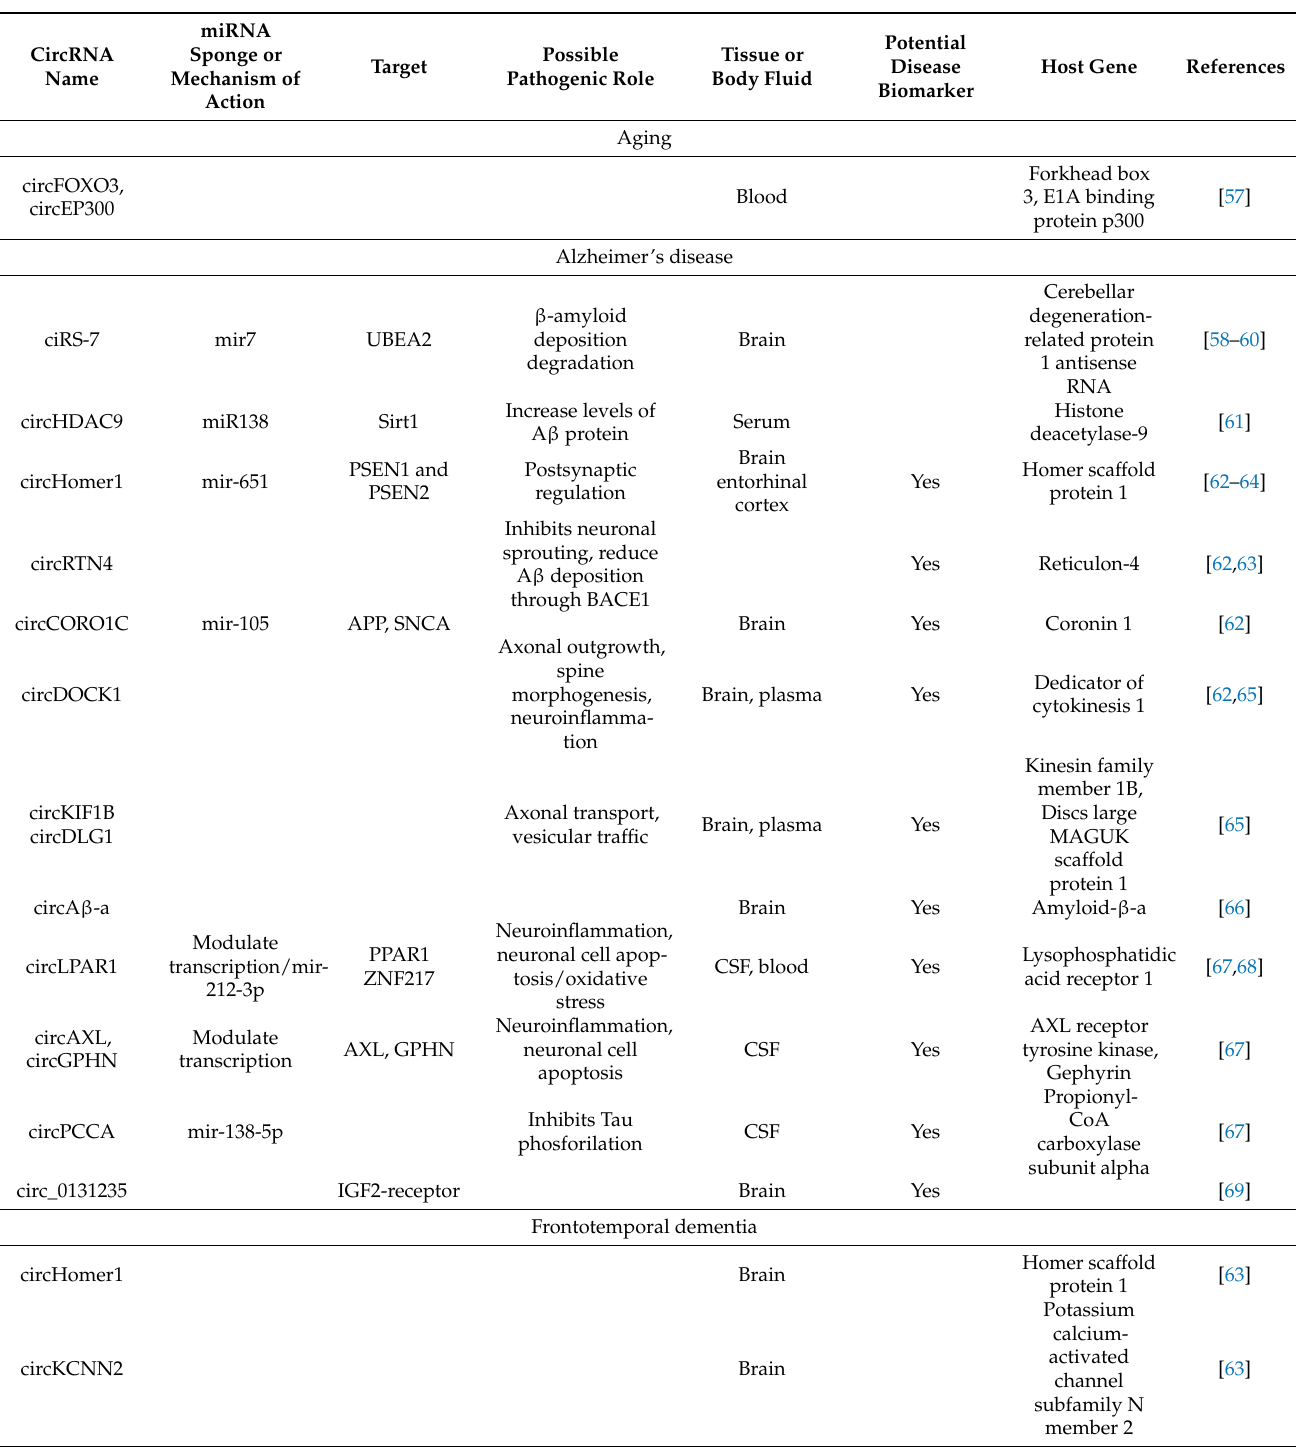
Table 1. circRNAs in aging, Alzheimer’s disease, Frontotemporal Dementia, and Parkinson’s